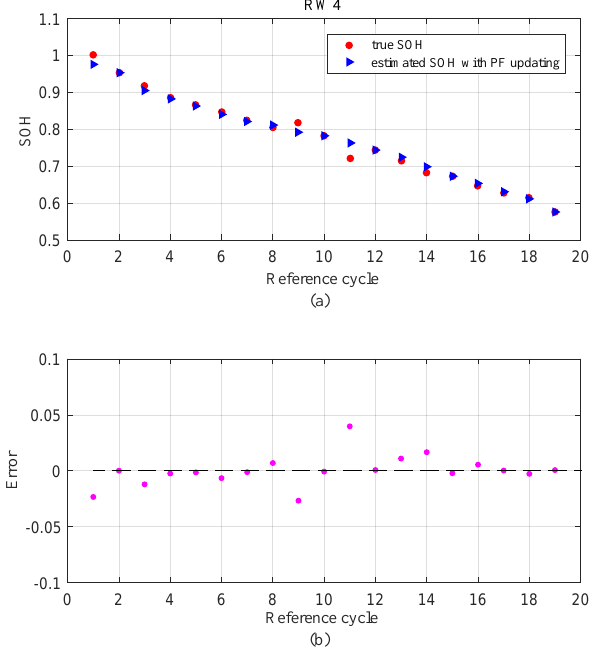
Figure 17. ( a ) SOH estimation results and ( b ) estimation errors for battery RW4 using indirect HIs with PF updating.